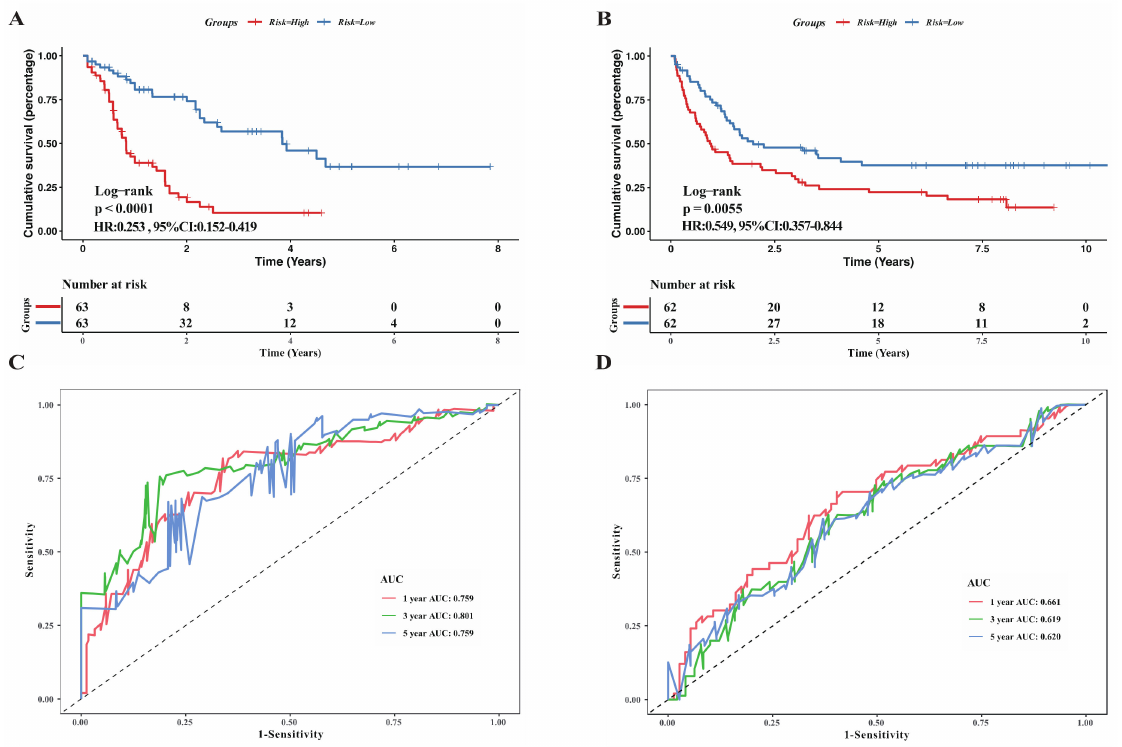
Figure 3. Assessment of ability of the risk signature to predict prognostic in both training and validation cohorts. ( A , B ) Kaplan-Meier survival curves reveal the difference of prognostic in two risk subgroups in TCGA cohort ( A ) and GSE37642 cohort ( B ). ( C , D ) ROC curves showing the predictive power of the risk model on the survival rate in TCGA cohort ( C ) and GSE37642 cohort ( D